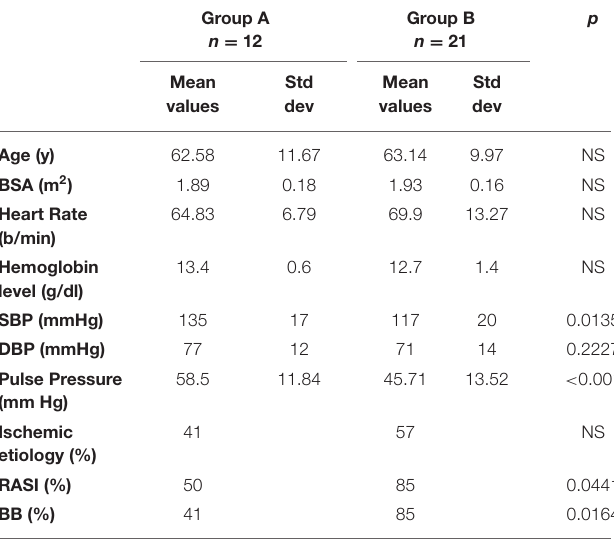
TABLE 1 | Demographical and clinical characteristics of the studied